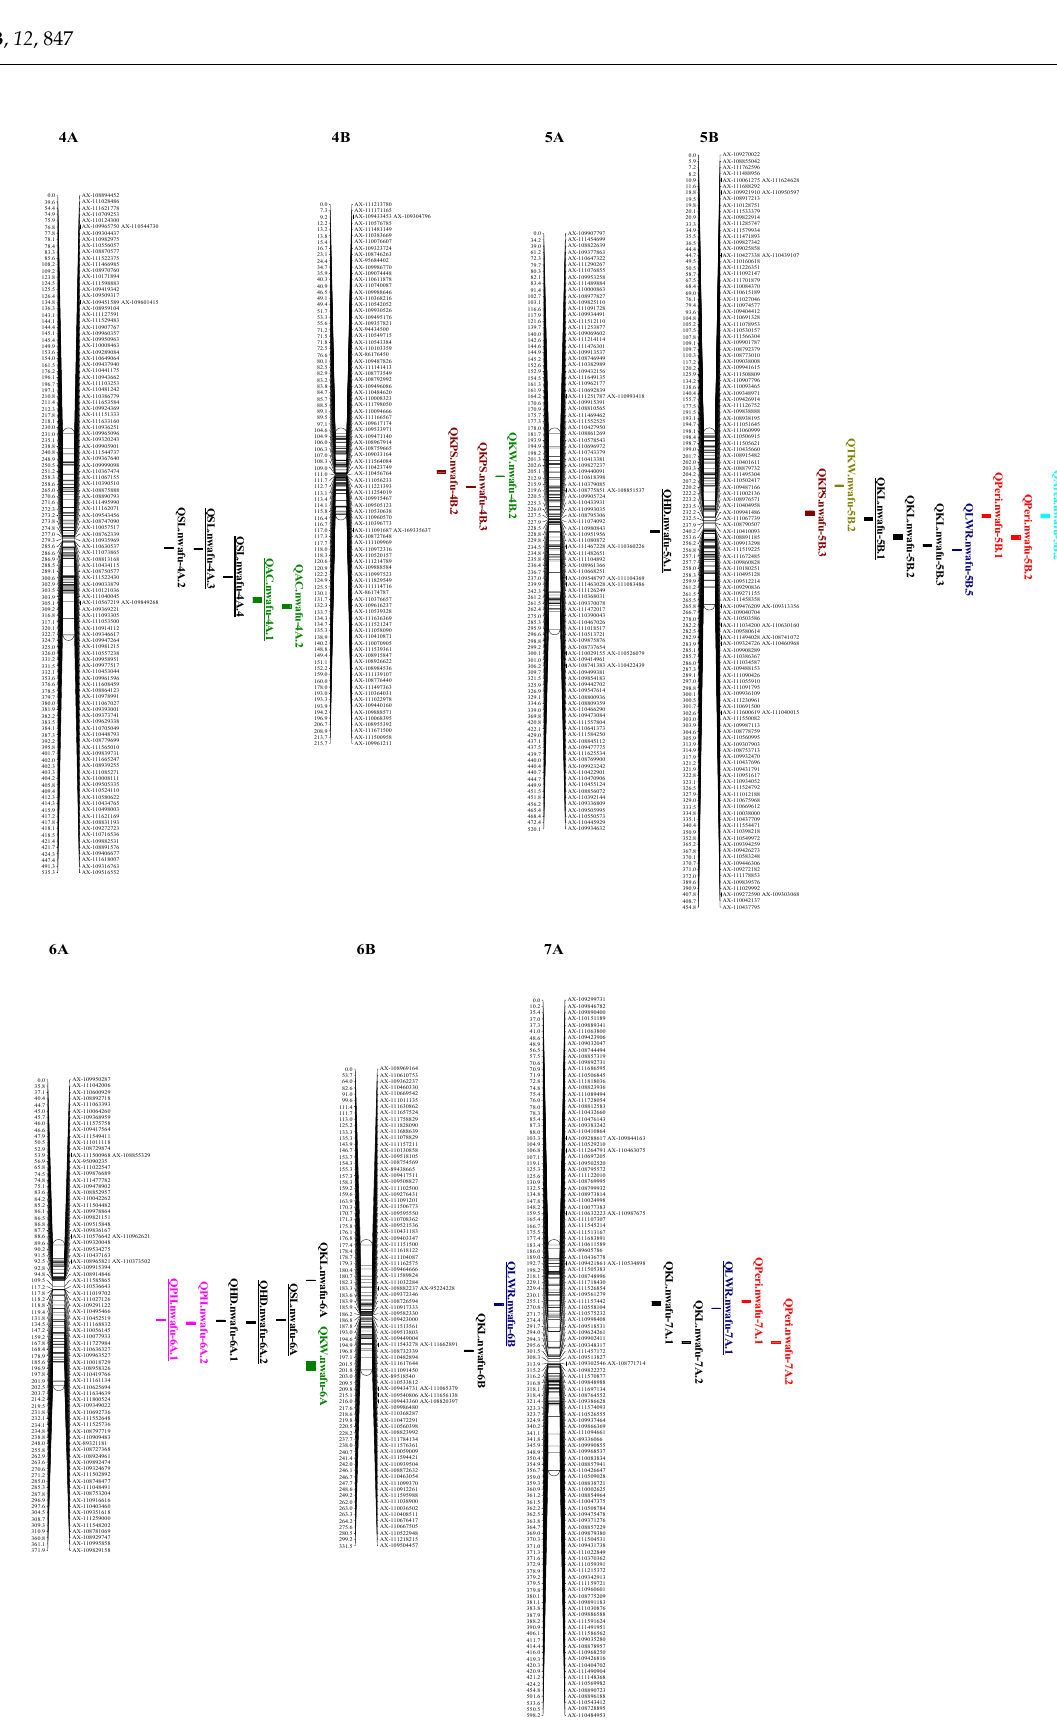
Figure 2. Chromosome positions of the major or stable additive QTLs for the 12 traits described in Table 1. The underlined QTLs indicate that they are the stable QTLs identified in this study. Different colors are used to distinguish different traits on the same chromosome.